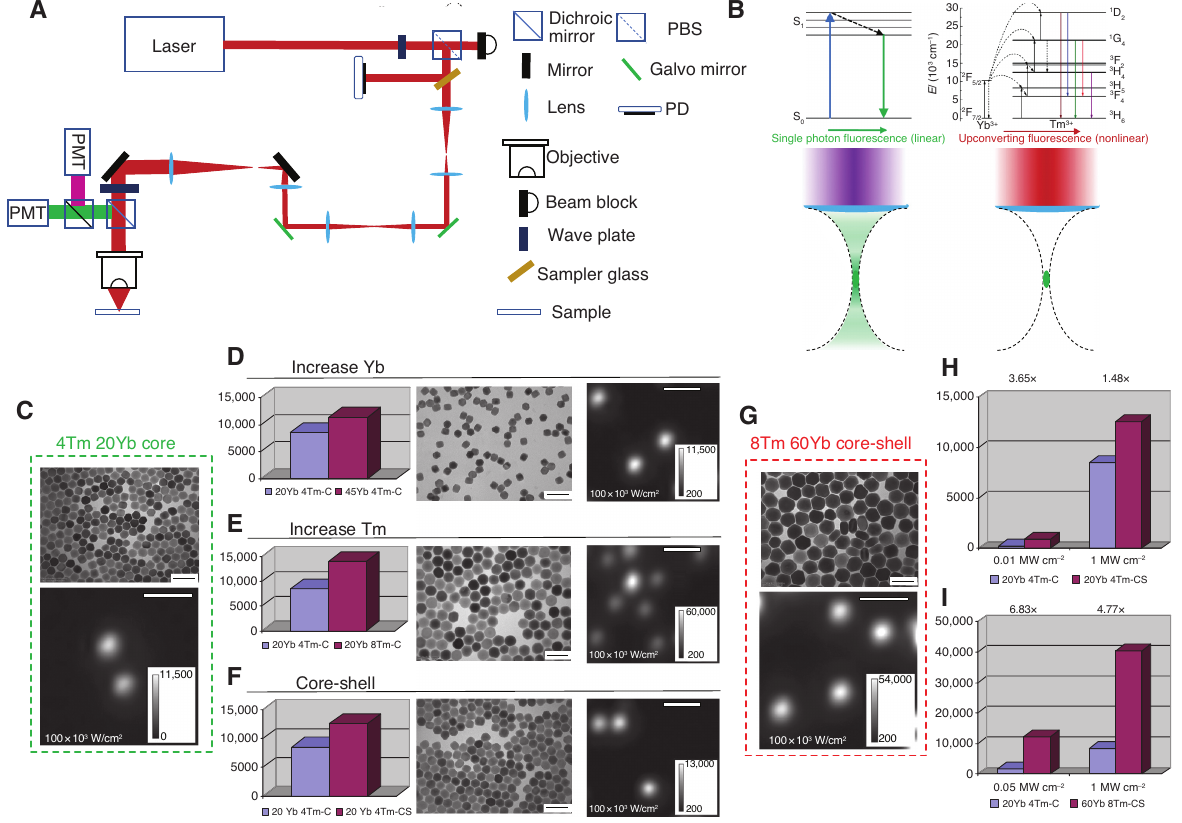
Figure 1: Multiple methods to increase upconverting luminescence for a single nanoparticle. (A) Schematic illustration of the system setup for customized LSM. The excitation source is a 980 nm CW laser (power density of 30 MW/cm 2 ) that is focused on the sample through an oil immersion objective lens (100 × , NA 1.4, Olympus). The dichroic mirror into the detector reflects the emission from the sample. A large field PMT (Multialkali Amplified PMT, PMT1001, Thorlabs) detector is employed to collect emission fluorescence photons. Scanning is achieved by two conjugated placed galvanometer mirrors. A motorized wave plate and a polarizing beam splitter (PBS) are employed to control the power, and a cover glass and photon diode (PD) is used to measure the power on the sample after objective remotely. (B) Spatial confinement of generated fluorescence generation with upconverting nonlinear excitation. In one photon fluorescence process, the whole illumination cone will generate a fluorescence signal, but the upconverting nonlinear generated signal only localized the focal spot. Upconverting nonlinear process generated a fluorescence photon by absorbing more than two photons, whereas one photon fluorescence process case absorbs one photon. TEM images and microscopy quantitative measurement of the whole upconverting spectrum luminescence emission of single UCNPs of (C) NaYF : 4% Tm 3 + , 20% Yb 3 + UCNPs; (D) NaYF : 4% Tm 3 + , 45% Yb 3 + 4 4 UCNPs; (E) NaYF : 8% Tm 3 + , 20% Yb 3 + UCNPs; (F) NaYF : 4% Tm 3 + , 20% Yb 3 + @ NaYF UCNPs; and (G) NaYF : 8% Tm 3 + , 60% Yb 3 + @ NaYF 4 4 4 4 4 UCNPs. Scale bar in TEM and fluorescence images, 100 nm and 1 μ m, respectively. The pixel dwell time in fluorescence image acquisition is 200 μ s. Comparison of integrated single-particle upconverting luminescence emissions of (H) core (4% Tm 3 + , 20% Yb 3 + ) and core-shell and (i) NaYF : 4% Tm 3 + , 20% Yb 3 + vs. NaYF : 8% Tm 3 + , 60% Yb 3 + @ NaYF UCNPs under different excitation 4 4 4 Based on a previous report, a brighter upconvert- Yb 3 + (Figure 1C)-doped particles under 1 MW/cm 2 power ing luminescence can be obtained under high excitation density. Increasing Yb 3 + concentration will decrease power in high activator concentration (4% Tm 3 + ) codoped the atomic distance from sensitizers to activators; thus, energy transfer will be more efficient when high exci- with 20% Yb 3 + UCNPs [39]. We tried to use a higher activa- tation power continually transfers energy from Yb 3 + to tor concentration to further increase luminescence, which is 8% Tm 3 + -doped UCNPs. As shown in Figure 1E, the same activators. The luminescence intensity of single nano- particles with different dopant concentrations has been trend occurs such that luminescence is enhanced 1.64 measured using a customized laser scanning microscope times higher. (LSM; Figure 1A). The luminescence intensity of a single Concentration quenching also can be overcome nanoparticle is represented as the maximum pixel value at high excitation powers by introducing a thin layer for each Gaussian spot. of an inert shell onto the surface of the nanoparticle.